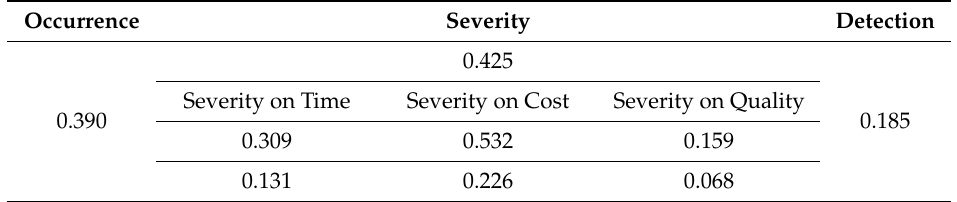
Table 6. Final weight vector.